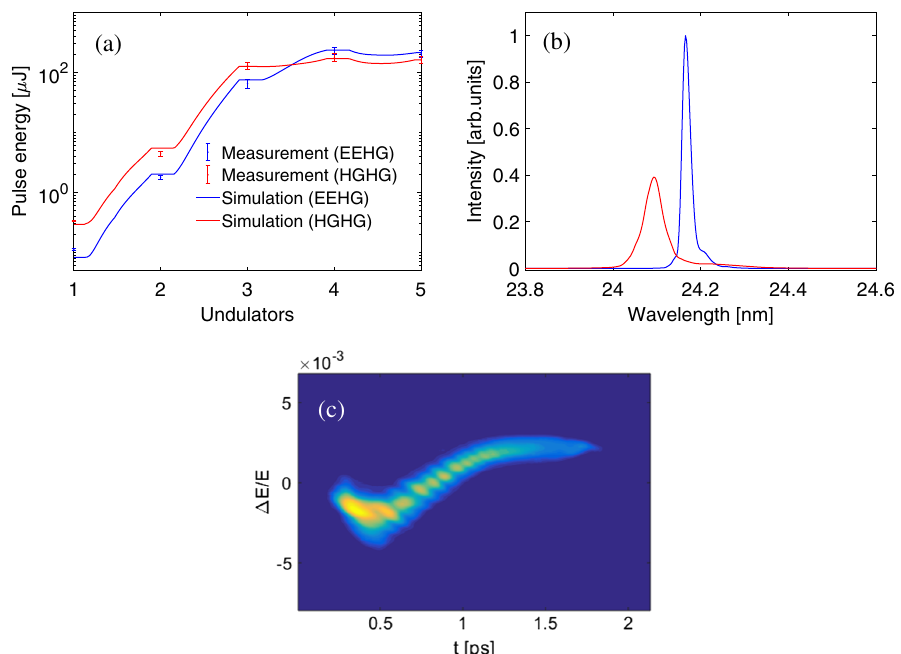
FIG. 4. Comparison of FEL gain curves (a) and spectra (b) for HGHG and EEHG at the 11th harmonic of the seed lasers (accumulated by 50 consecutive shots). (c) Measurement results of the longitudinal phase space of the electron beam by the X-band deflecting cavity at the end of the linac (bunch head to the